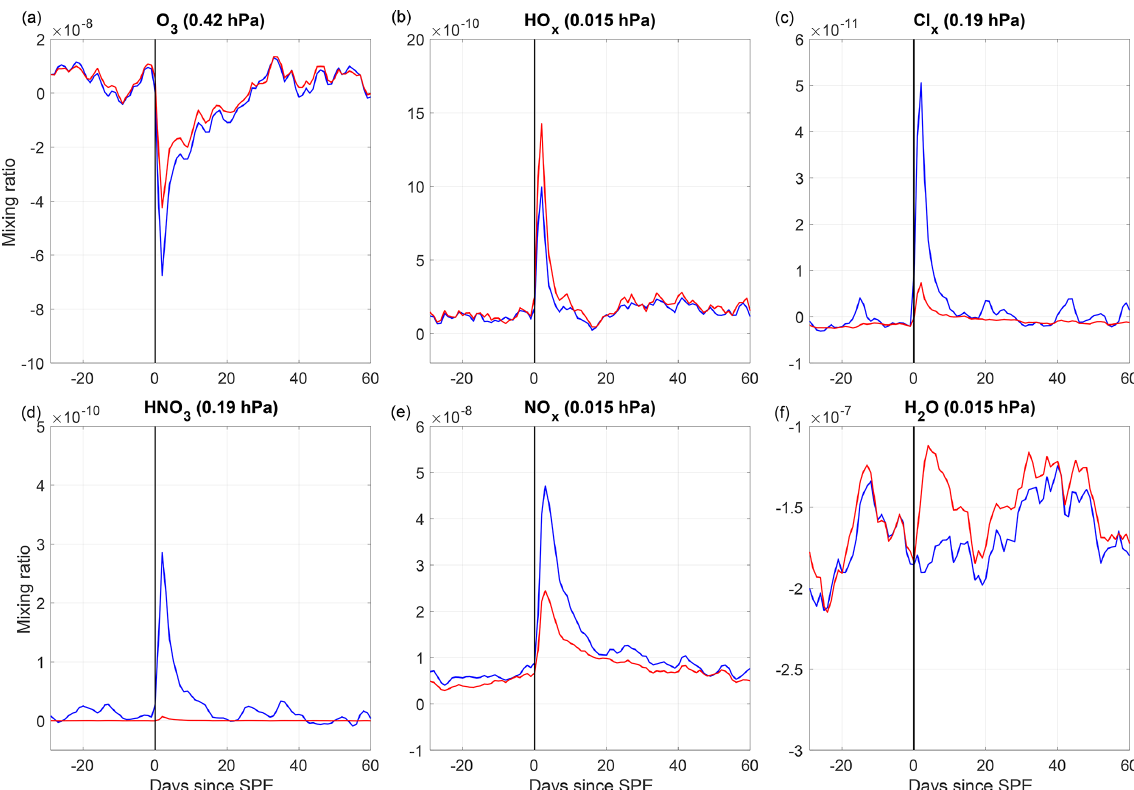
Figure 9. Composite mean (cid:100) WD (blue) and (cid:100) REF (red) for the southern polar cap (area-weighted, latitude > 60 ◦ S) at selected pressure bands (three pressure levels, pressure of the center of the band shown in panel title). The x axis shows the number of days before and after the event (day 0, solid black